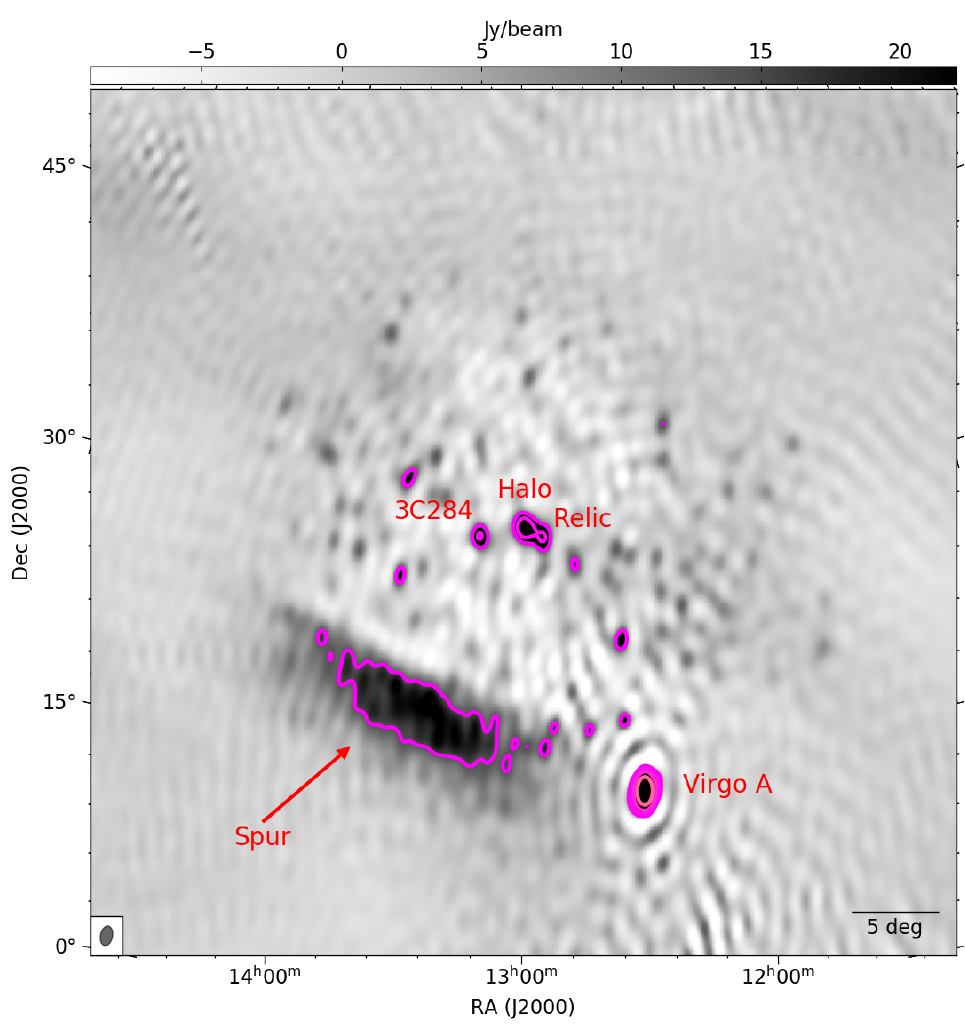
Figure 3. Apparent sky brightness distribution image of the NenuFAR field of view, centred on the Coma cluster, 2 hour integration time. Green corresponds to negative flux values, i.e., artefacts. The noise near Coma is 2 Jy beam − 1 , and the pink contours are the image overlaid on itself starting at 3 σ . The restoring beam size is shown in the bottom